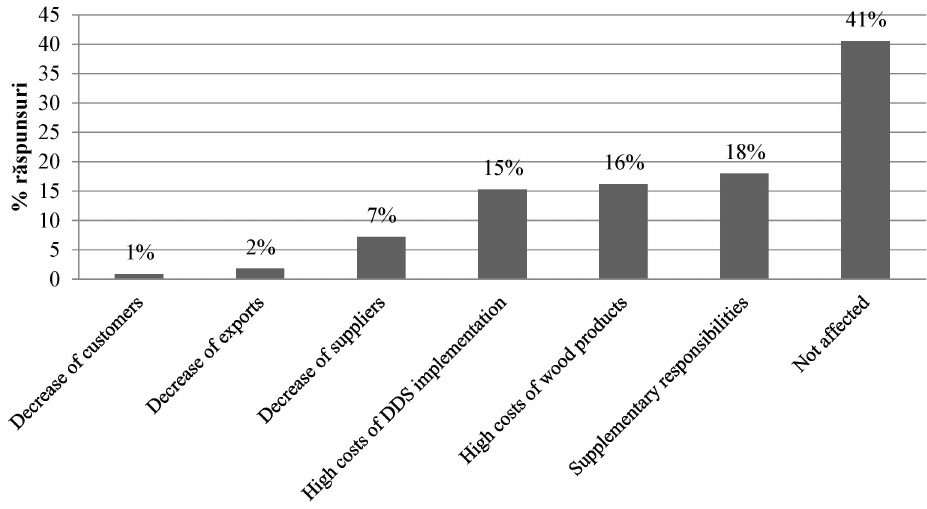
Figure 4. Impact of EUTR application on company